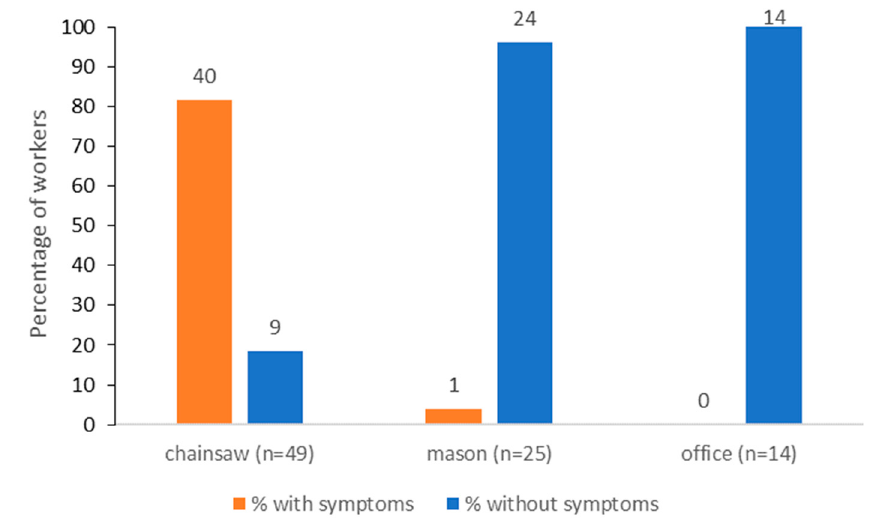
Figure 2. Frequency of symptoms associated with the exposure to the pine processionary moth in forestry workers assigned to different tasks.